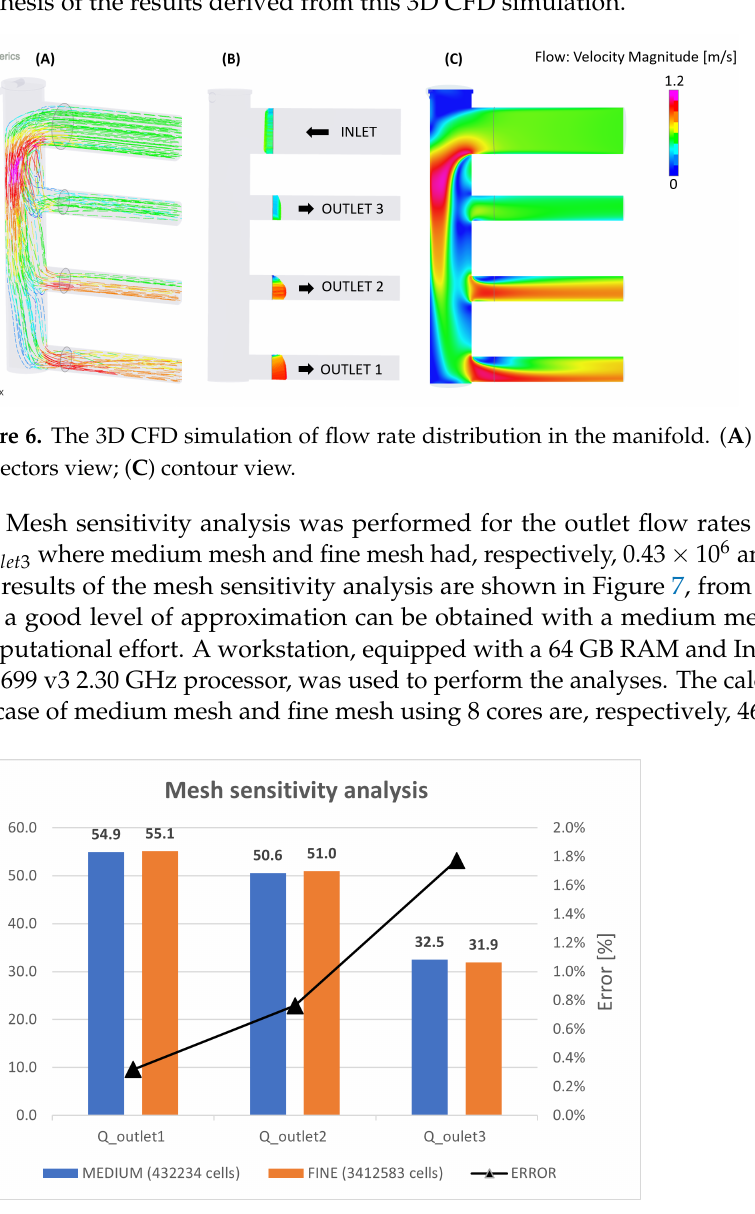
Figure 7. Mesh sensitivity